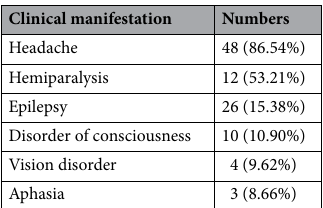
Table 1. Clinical manifestations of 56 patients.